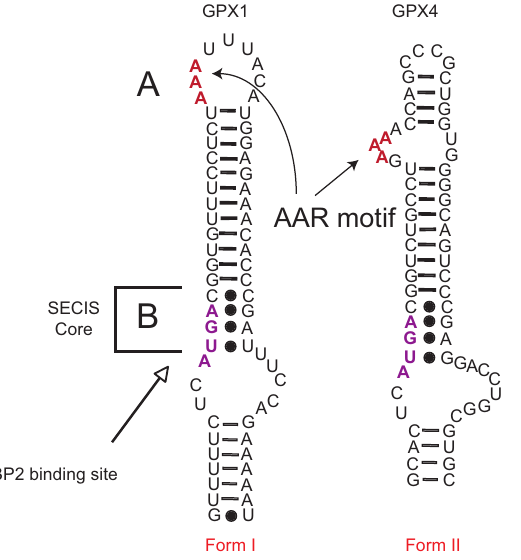
Figure 1 Predicted SECIS element structures for GPX1 (form I) and GPX4 (form II). (A) The forms differ by the position of the conserved AAR motif (red), which is in the terminal loop for form I and in a 5 ′ bulge in form II. (B) The conserved AUGA motif is shown in purple and represents the SECIS core, which refers to the region containing non-Watson-Crick base pairs. The basal stems (below the SECIS core) are not shown in their entirety and are of variable lengths.